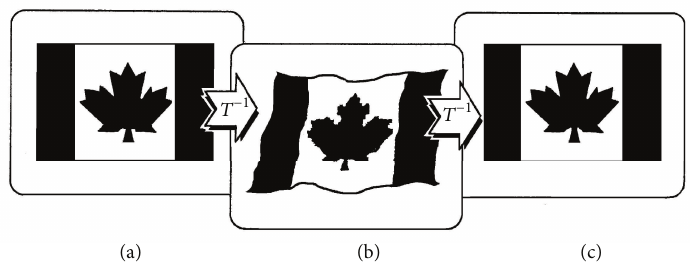
Figure 4: Harmonic distortion and restoration.